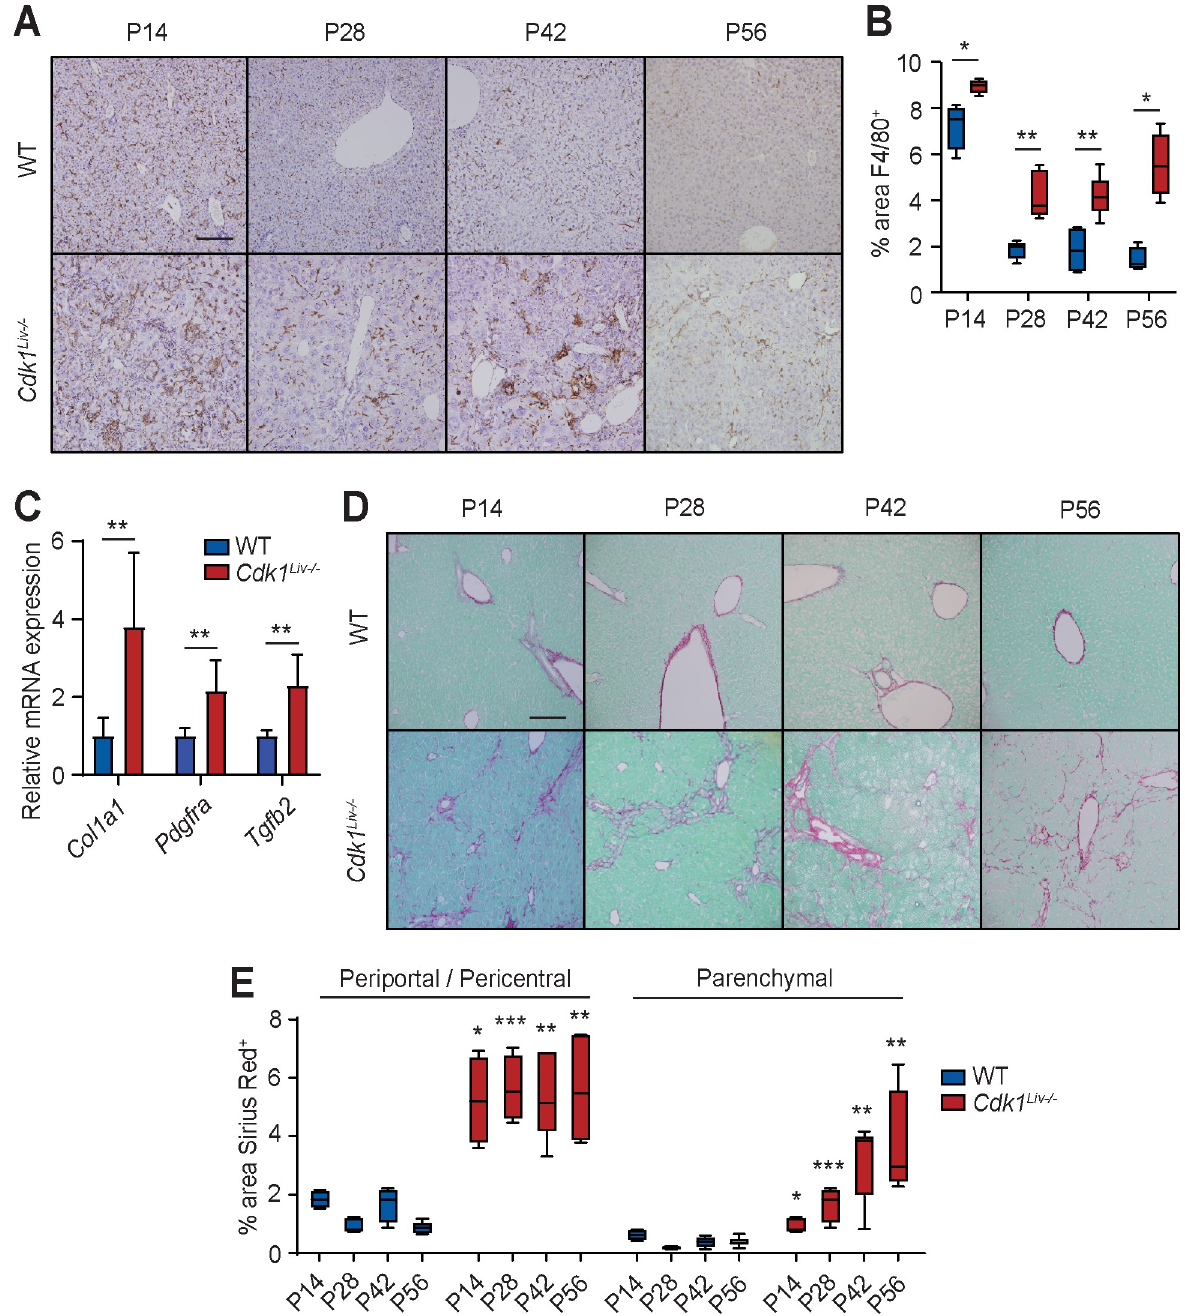
Fig 4. Cdk1 Liv-/- liver exhibits inflammation and fibrosis. (A) Representative immunohistochemistry images of sections stained for F4/80 (brown), a marker for macrophages, at different post-natal time points. (B) Quantification of F4/80 + cells using 5 images per mouse (at least n = 4 per genotype per time point). (C) qPCR for Col1a1 , Pdgfra , and Tgfb2 mRNA expression in whole liver sample (n = 6 per genotype). (D) Representative images of Sirius Red-stained liver sections at different post-natal time points. (E) Quantification of Sirius Red-stained area using at least 5 images per mouse (at least n = 4 per genotype per time point). Error bars of all graphs represent S.E.M. Scale bars of all microscopy images represent 50 μ m.